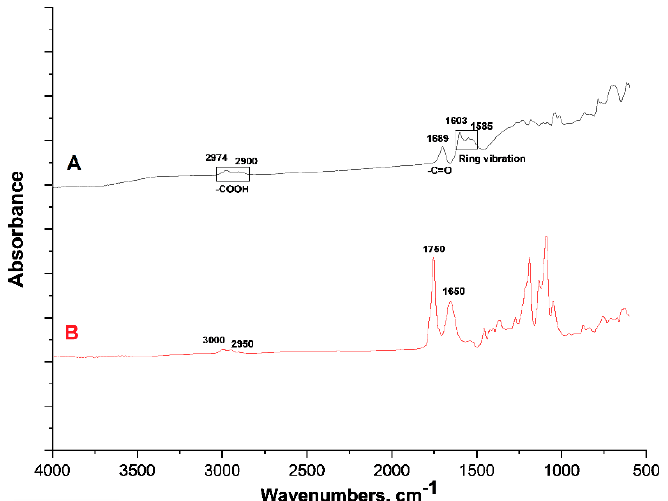
Figure 3. FTIR-ATR spectra: ( A ) surface-modified iron oxide (ZV) microparticles; ( B ) core–shell microparticles .